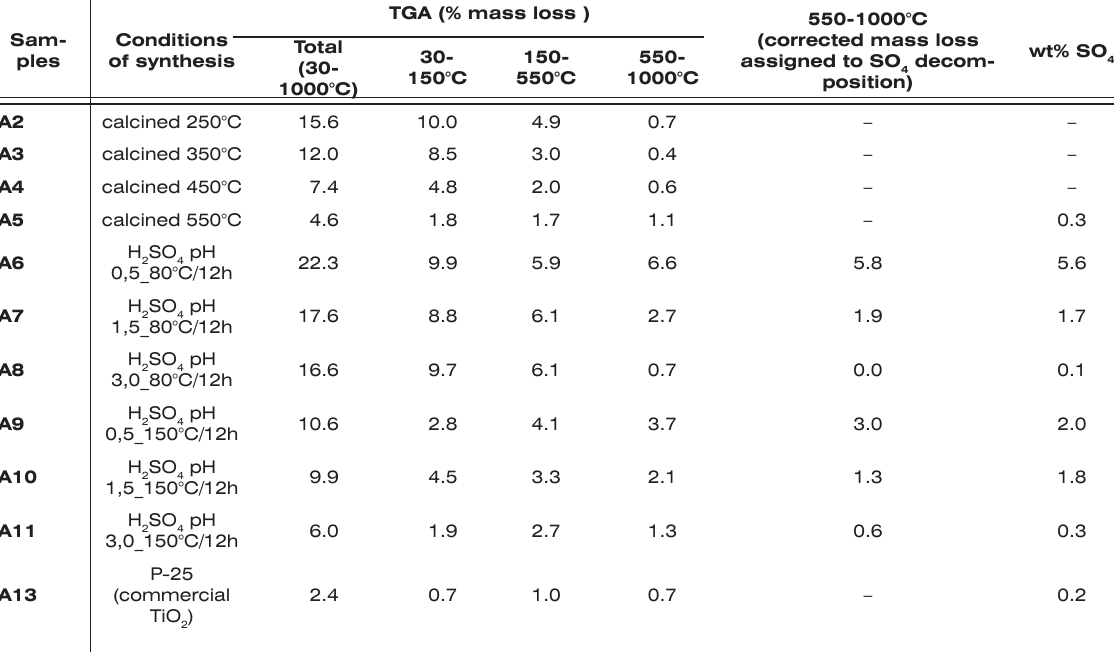
wt% estimated by TGA and determined by 4